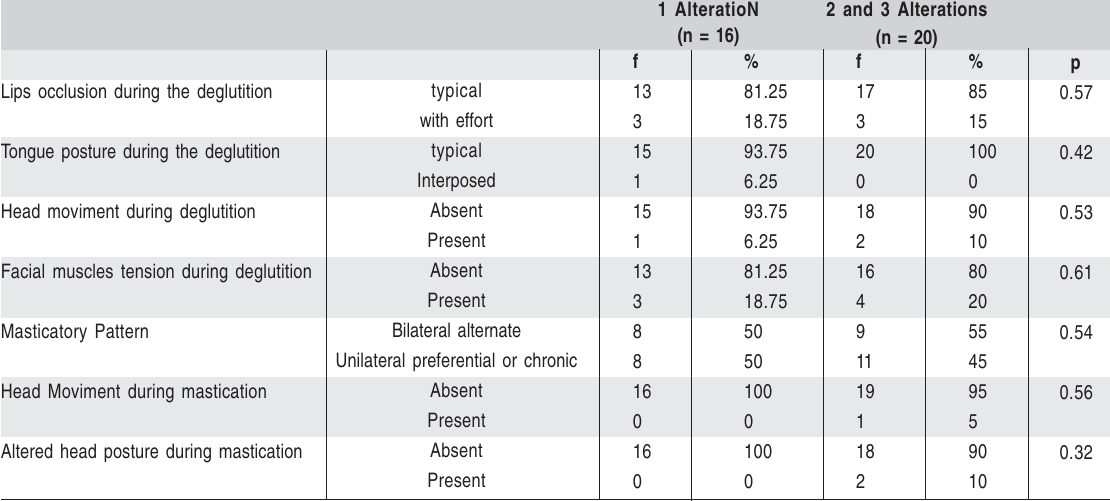
Table 3 - Presence of craniocervical posture changes (1 or 2 and 3) and its relationship with the masticatory and swallowing function